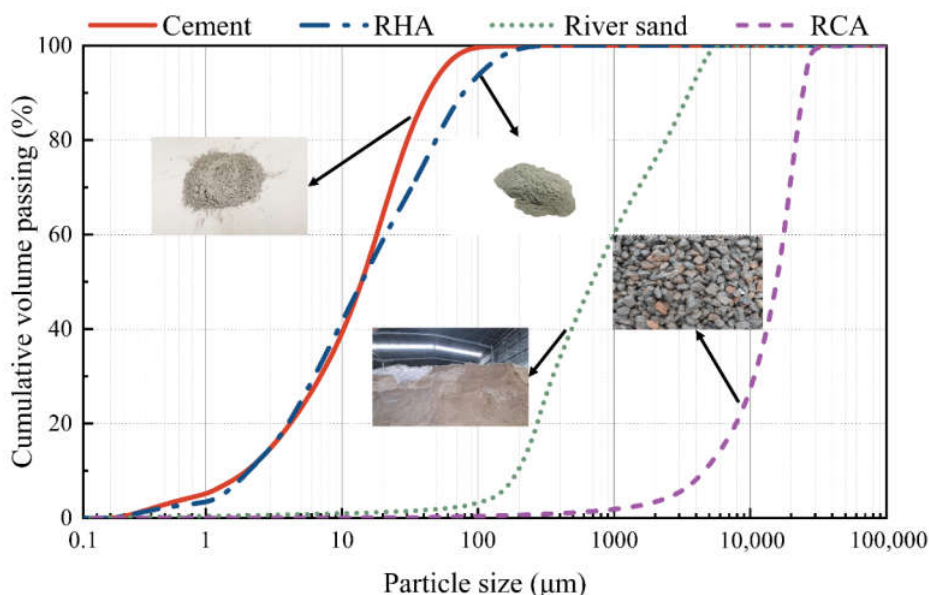
Figure 1. Microstructure of RHA measured by scanning electron microscopy.